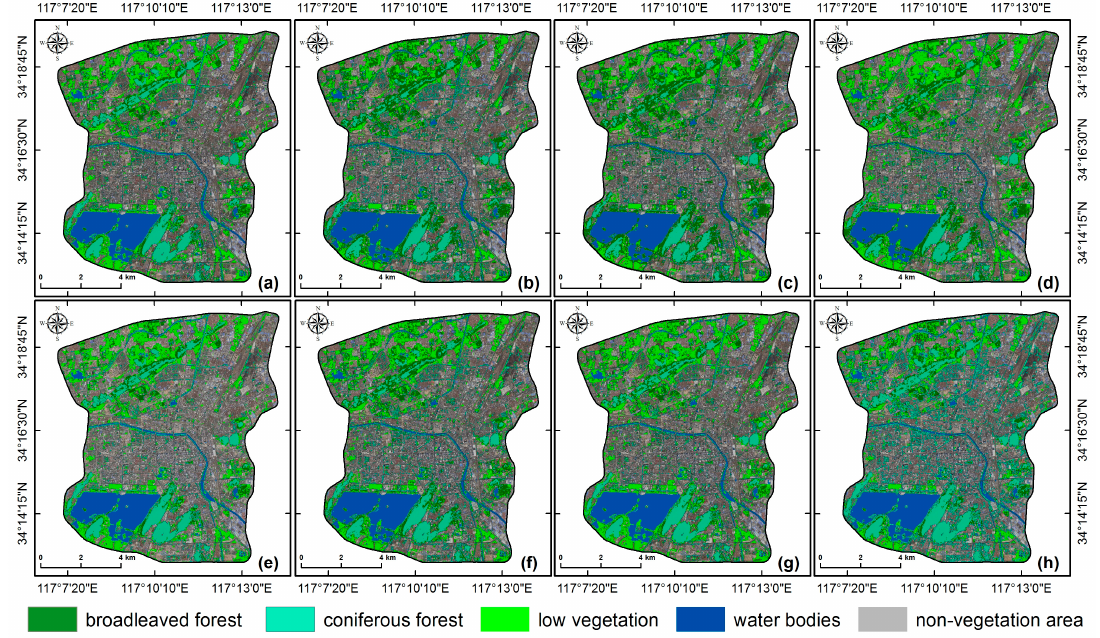
Figure 7. Land-cover maps produced by eight different classification models: ( a ) SVM; ( b ) RF; ( c ) ANN; ( d ) QUEST; ( e ) SVM + VA; ( f ) RF + VA; ( g ) ANN + VA; and ( h ) QUEST + VA.